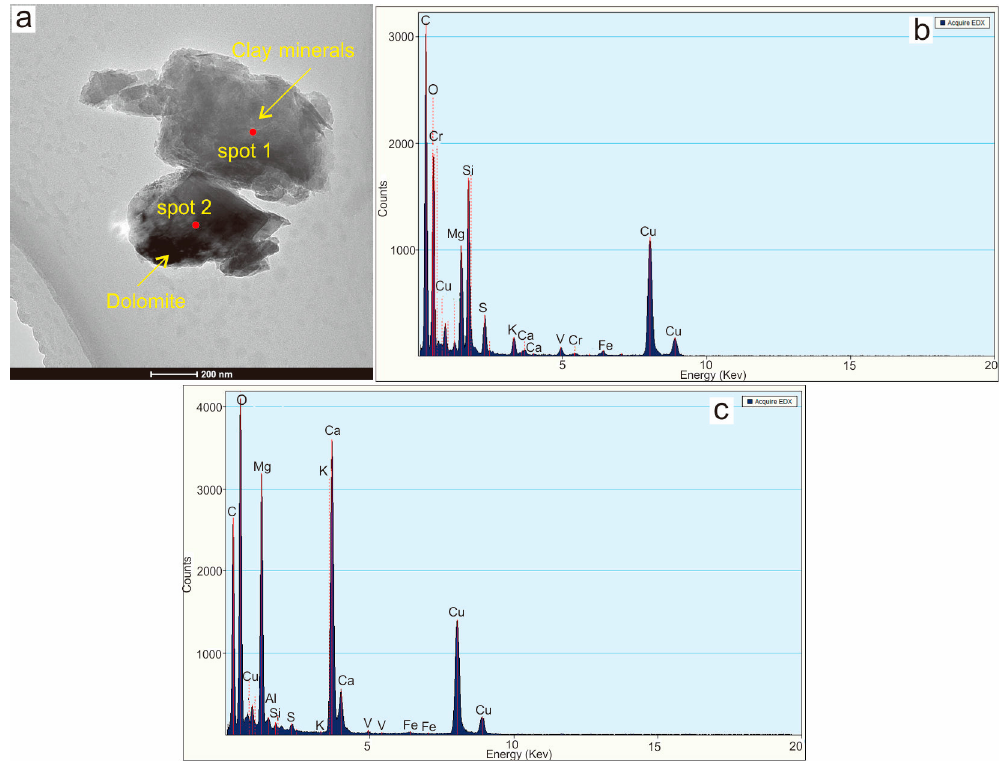
Figure 7. ( a ) Flotation-cleaned coal sample GH2, TEM; ( b ) the EDS spectrum of clay minerals in (a); and ( c ) the EDS spectrum of dolomite in ( a ).